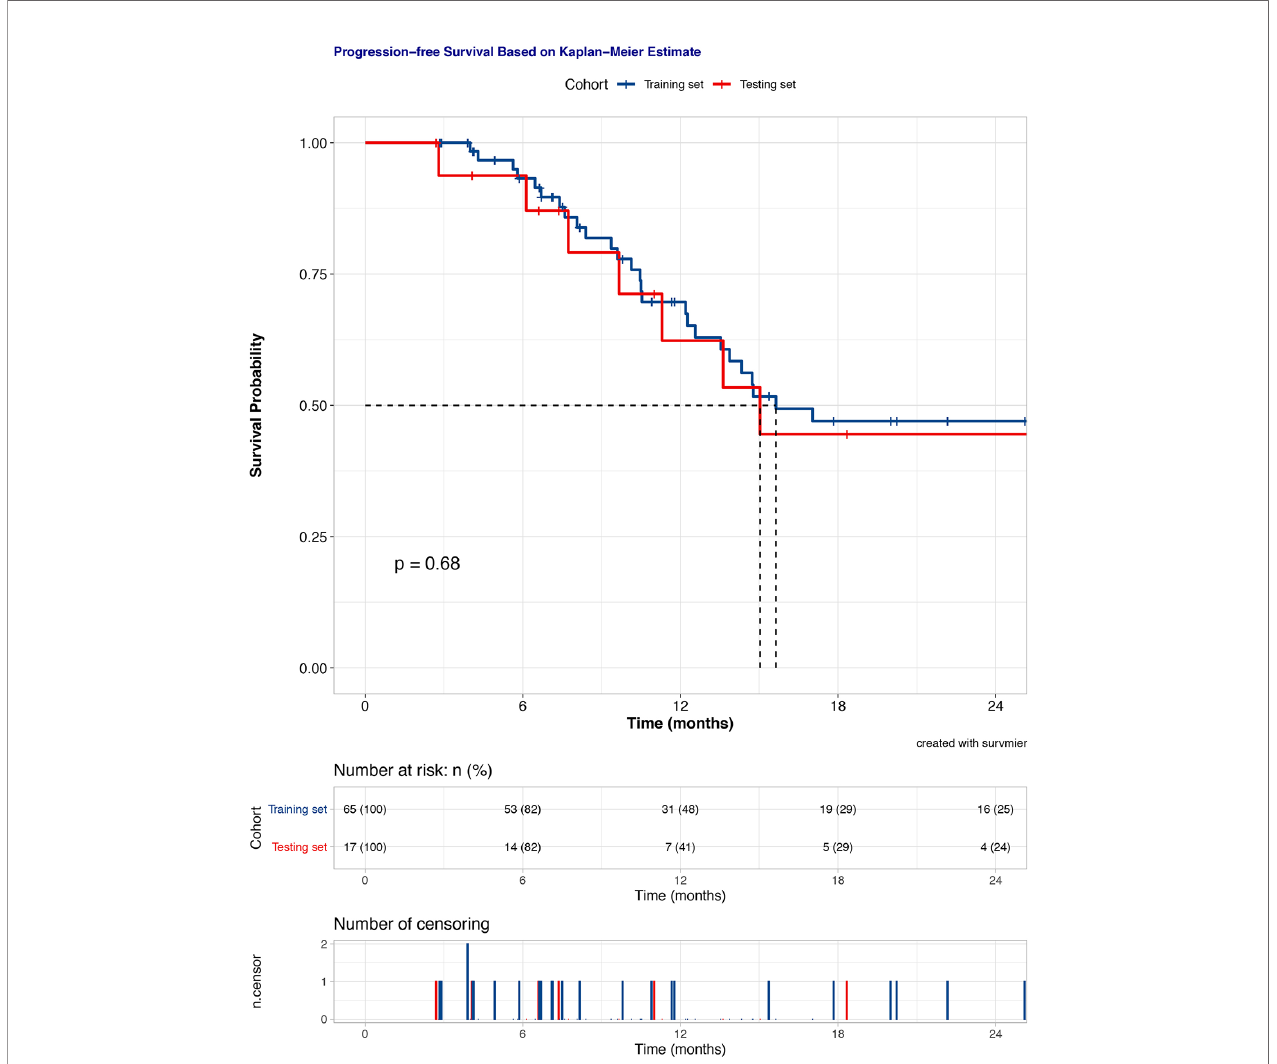
FIGURE 1 | Kaplan-Meier survival curves of progress-free survival for the training and testing